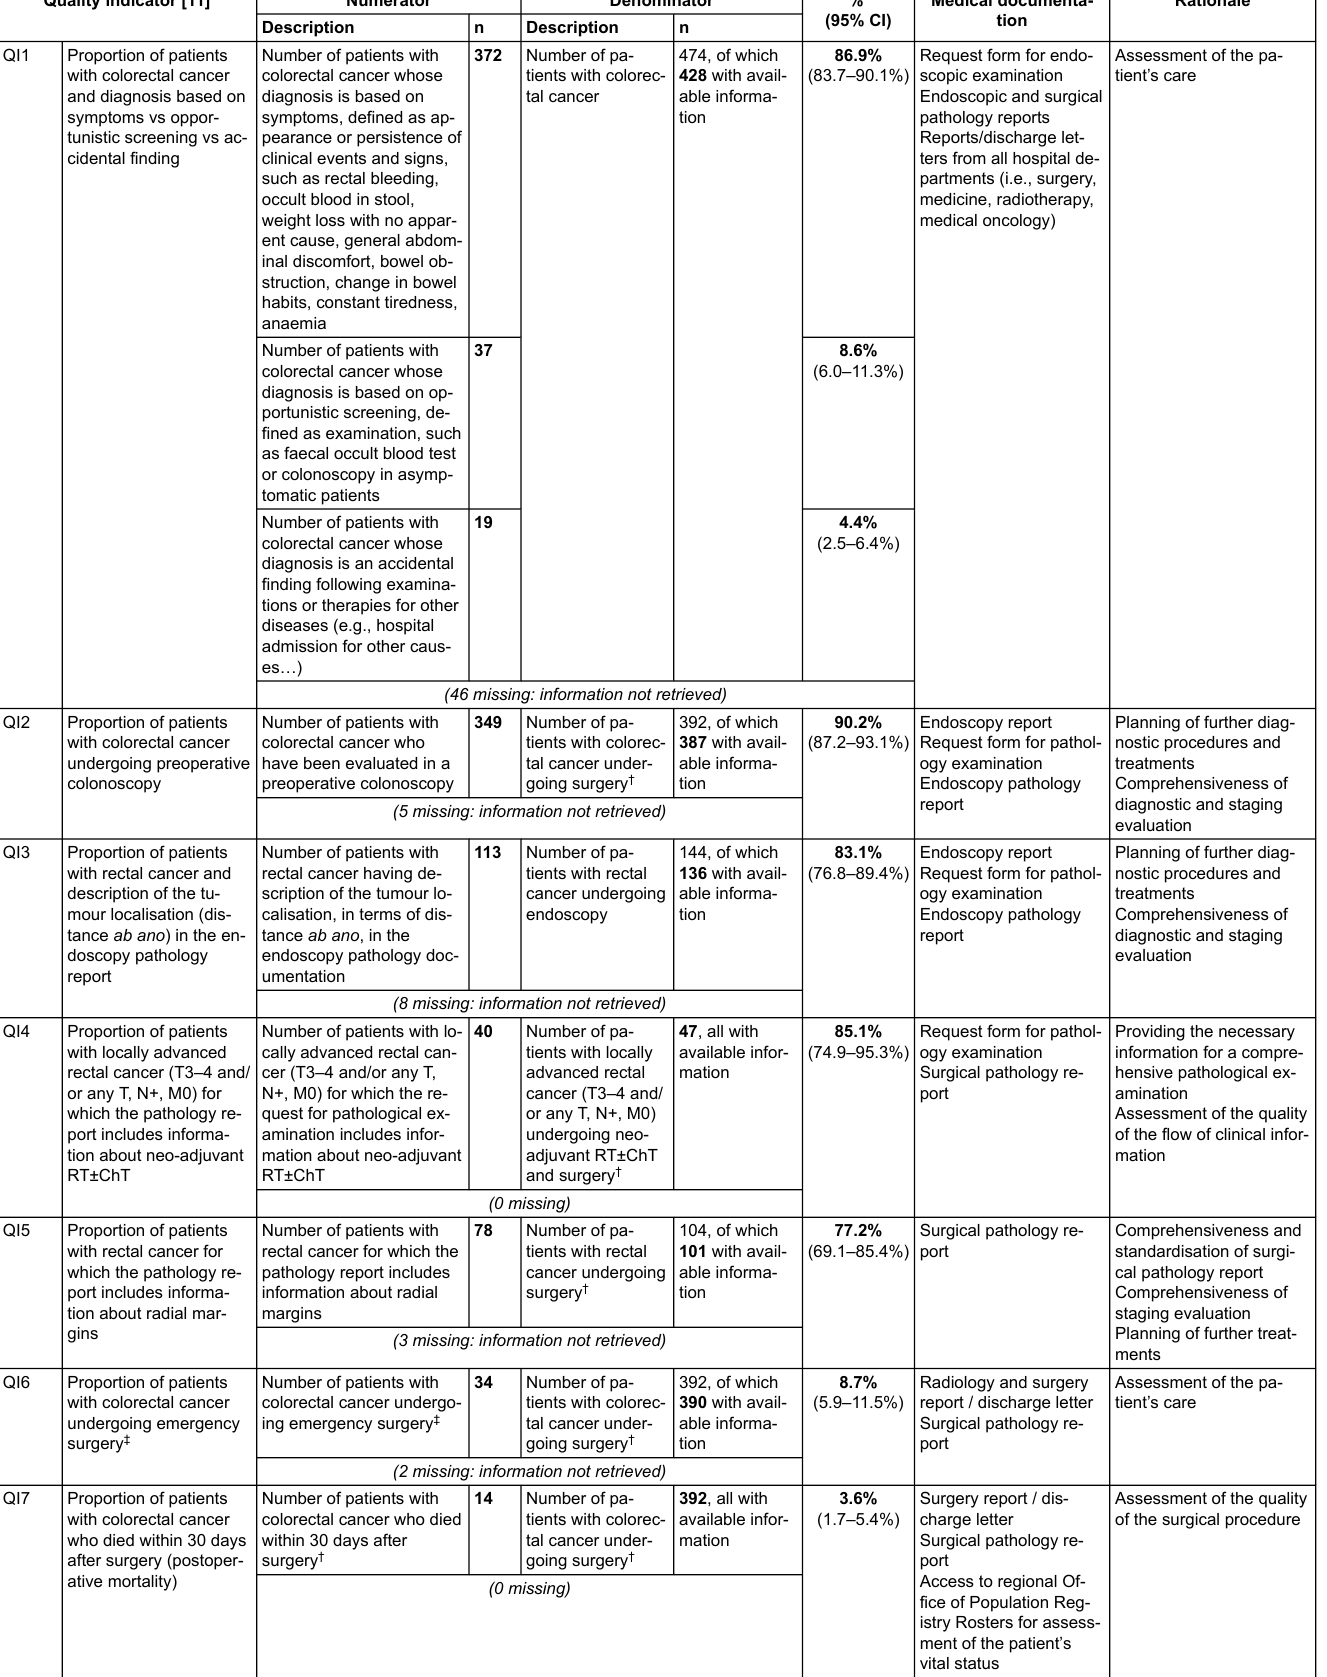
Table 1: Quality indicators (QI) for patients diagnosed with colorectal cancer in southern Switzerland between 2011 and